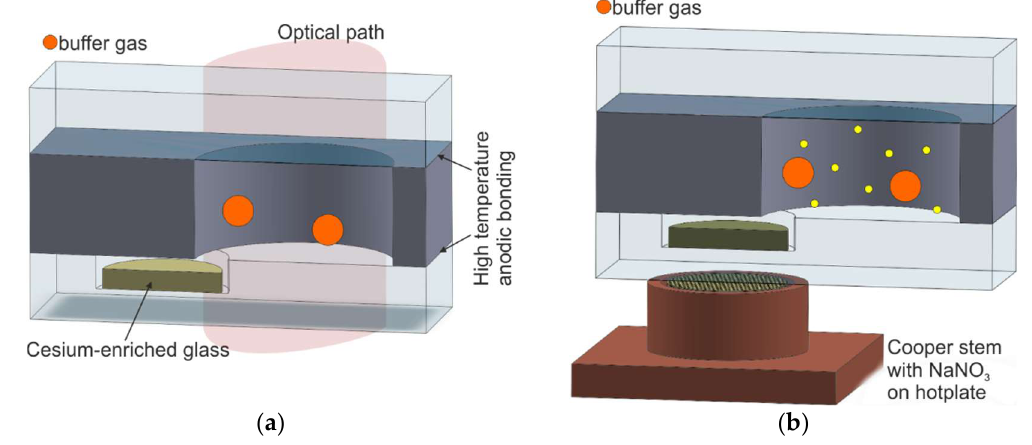
Figure 9. Process of electrolytic alkali metal introduction: ( a ) cross section of the MEMS cell, ( b ) alkali vapor introduction by means of electrolysis.